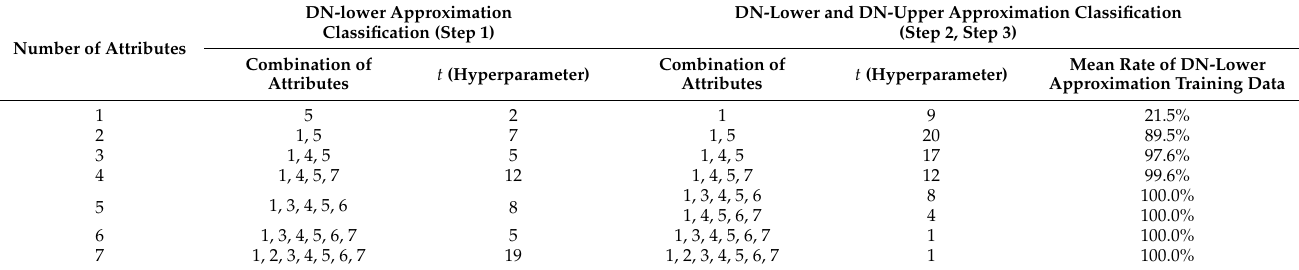
Table 8. Optimal hyperparameters of the DNRS model for